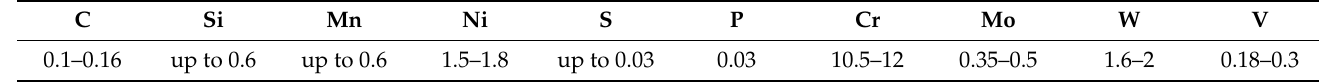
Table 1. Chemical composition of steel, wt.%.